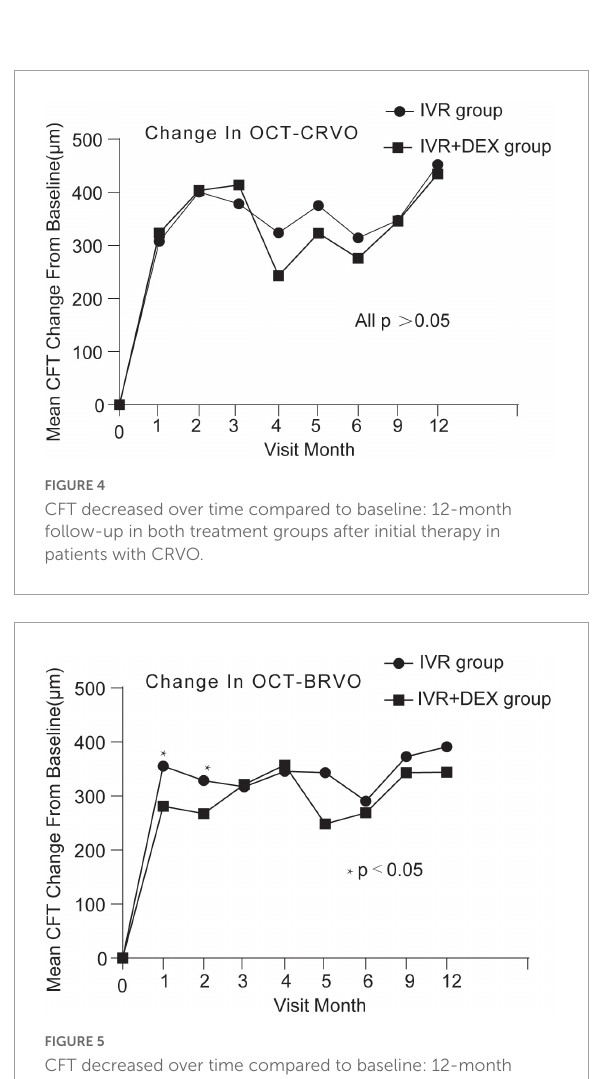
The mean total reinjection interval for all patients was 131.2 ± 8.9 days. The mean reinjection interval of CRVO and BRVO was 130.4 ± 10.2 (range: 98–145 days) and 134.6 ± 9.5 (range: 119–150 days), respectively. No statistically significant difference was detected in the mean intertreatment interval between the eyes with CRVO and BRVO ( p =